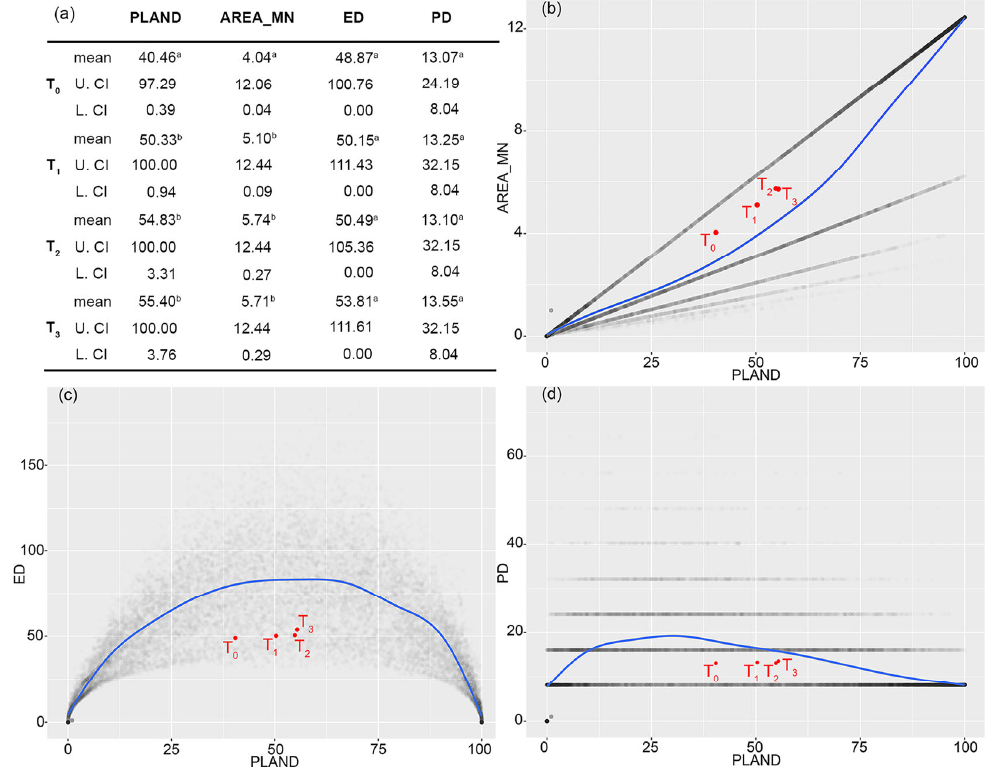
Figure 5. Trajectory analysis on numbers ( a ) and Cartesian graphs ( b – d ) of urban expansion cells. ( a ) Table reporting the mean, upper (U. CI) and lower (L CI) confidence intervals of each landscape metric (PLAND: proportion of land covered by urban areas, AREA_MN: mean urban patch area, ED: edge density, PD: patch density) over time, with a, b indicating significant differences. ( b – d ) Cartesian relationship spaces reporting measured configuration metrics (grey dots) in relation to urban cover, along with the relative fitted curves (blue line) and the mean metric values (red dots) for each time step (T 0 , T 1 , T 2 , T 3 ).